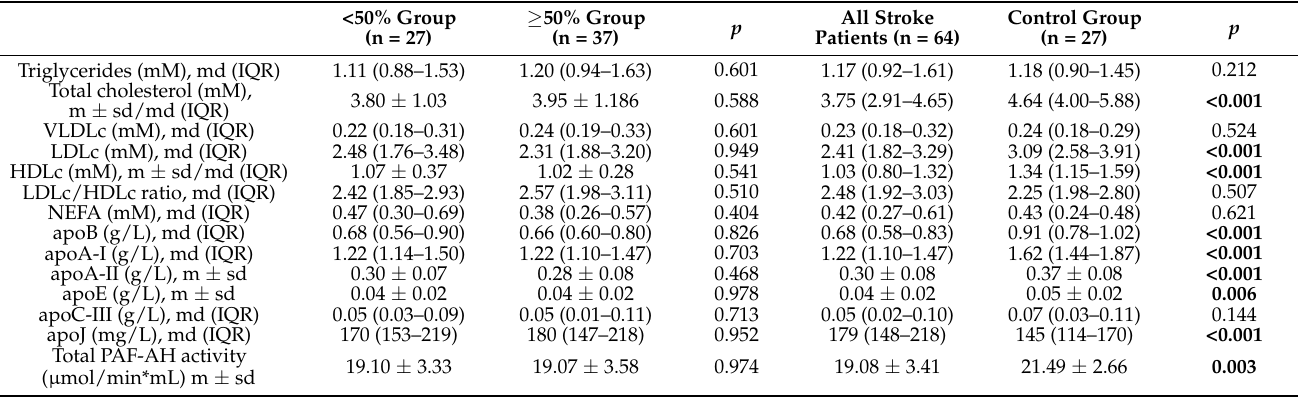
Table 1. Concentration of lipid profile and lipoprotein-related parameters according to the study